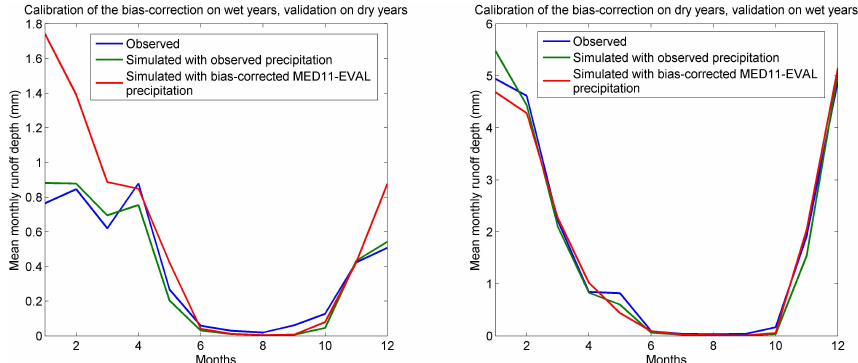
Fig. 12. Discharge simulations obtained with observed and bias-corrected precipitation form MED11-EVAL during dry (left panel) and wet years (right